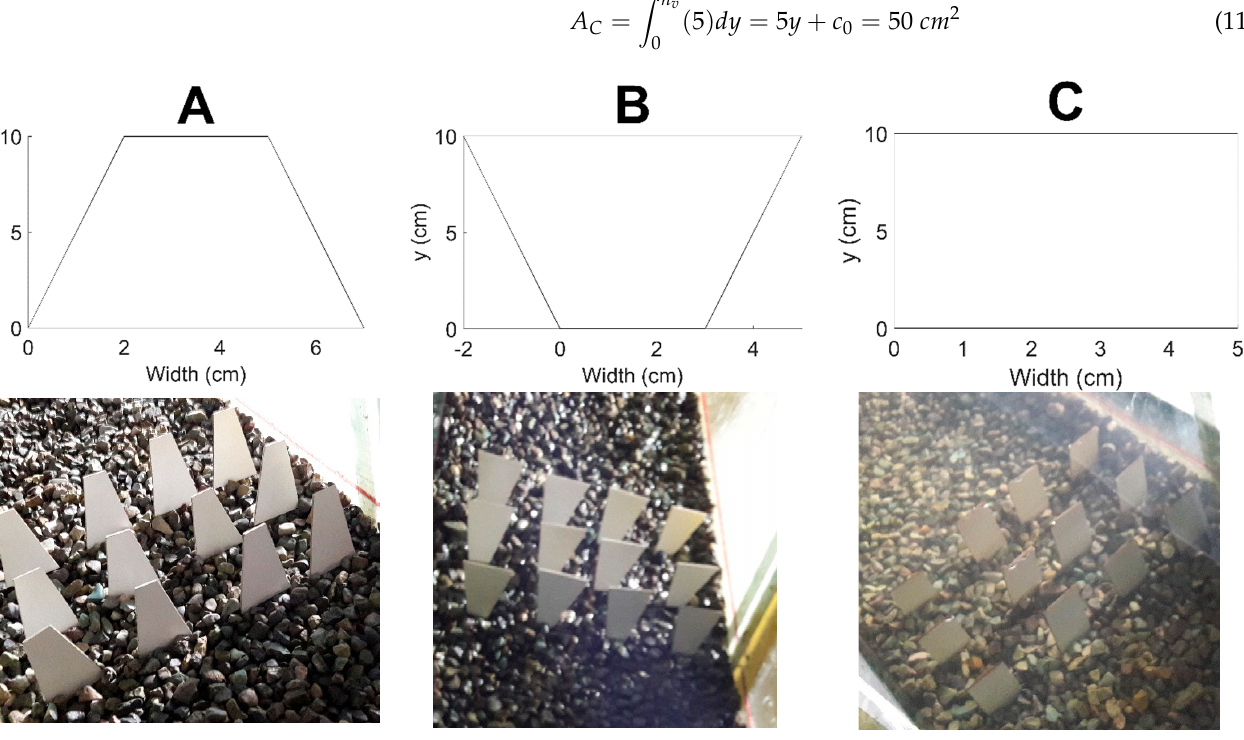
Figure 1. Sketches and real pictures of vegetation model type ( A − C ).